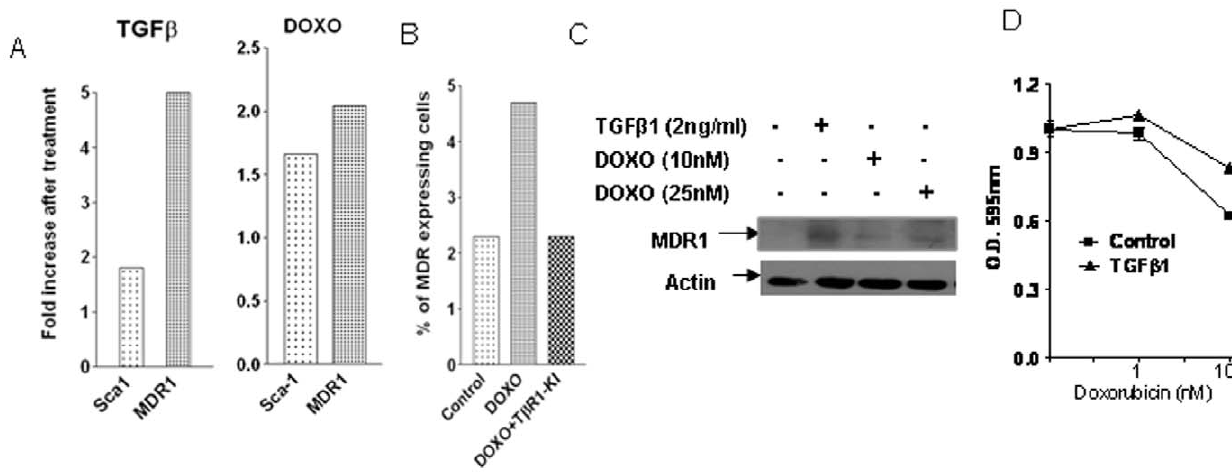
Figure 4. Doxorubicin and TGF b treatment generated drug resistant cells with a stem cell phenotype. A and B. The murine 4T1 breast cancer cells were treated with TGF b 1 (2 ng/ml) or doxorubicin (25 nM) in the presence or absence of TbRI-KI (500 nM) for 7 days. The medium was changed every alternate day. The treated and non-treated cells were harvested with trypsinization and incubated with an alexafluor 405-conjugated antibody (2 m g/10 6 cells) against MDR1 or a Phycoerythrin-conjugated antibody against Sca-1. Fluorescence Activated Cell Sorting (FACS) analysis was carried out using FACSAria flow cytometer (Becton Dickinson). Results were expressed as fold increase of the number of cells expressing the surface markers for Sca-1 or MDR1 after treatment with TGF b 1 or doxorubicin compared to the untreated cells ( A ) or as the percentage of MDR1 expressing cells after doxorubicin treatment in the presence or absence of T b R1-KI ( B ). C. 4T1 cells were treated with or without 2 ng/ml TGF b 1 and DOXO (10 nM and 25 nM) for 7 days and cell extracts were used for Western blot analysis with antibody to MDR1. D. 4T1 cells, pre-treated with TGF b 1 (5 ng/ml) for seven days, were plated in a 96-well plate and were treated with doxorubicin at two different concentrations (1 nM and 10 nM) in the presence or absence of TGF b 1 (5 ng/ml). Relative cell number after 5 days of incubation was obtained by MTT assay. Each data point is the mean 6 SEM from 4 replicate wells.